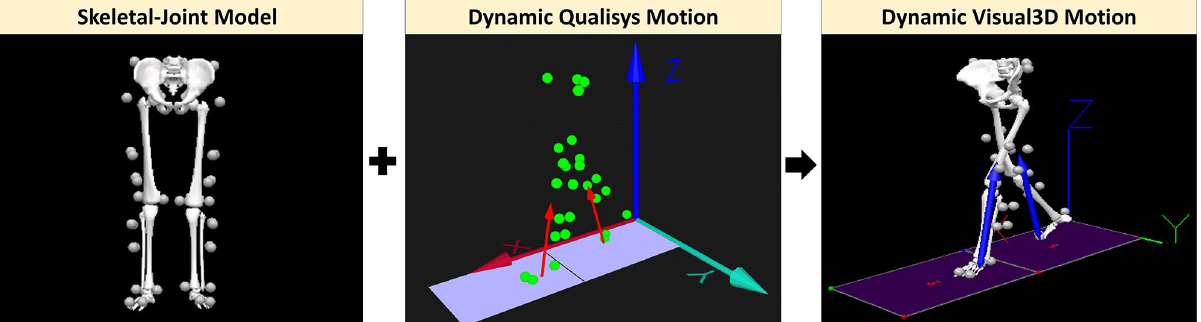
Figure 5. Visual3D data digitizing process in three steps namely; 1. Construction of the static skeletal-joint model, 2. Insertion of the dynamic Qualisys motion files to the static skeletal-joint model which transforms its static motion to dynamic motion, and 3. Extraction of gait parameters through analysing the motion of the dynamic skeletal-joint model. The gray and green circles denote the attached markers. The vertical arrows denoted the vGRFs measured from the force plates. The two force plates are depicted in squares. The images of Skeletal-Joint mModel and Dynamic Visual3D motion, were screen captured from Visual3D Lite v4.96.11 37 (C-motion Inc., Kingston, Canada). Dynamic Qualisys Motion image was screen captured from the Qualisys Track Manager 2.6 38 (Qualisys, Göteborg, sagittal plane. Hip flexion/extension was calculated using trunk and thigh segments. Knee flexion/extension, was determined from the thigh and shank segments. Ankle plantar/dorsiflexion was computed by shank and foot segments. vGRFs were computed from analogue signals of the force plates. The extracted gait timings t IC , t NIC , t ITO , and t NTO correspond to events IC, NIC, ITO, and NTO respectively. t IC , t NIC , t ITO , and t NTO were used for partitioning the gait signal into a single gait cycle (from IC to NIC or ITO to NTO). All measured data samples